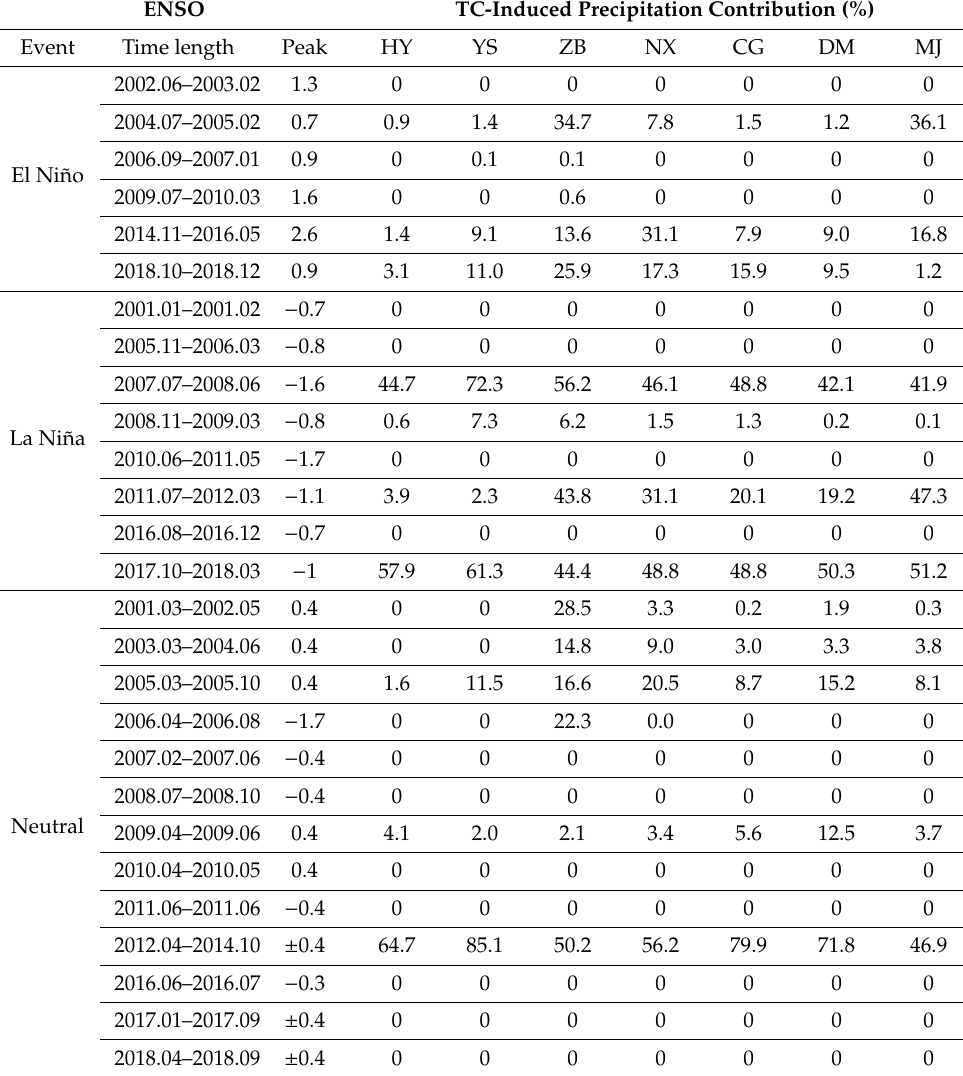
Table 3. ENSO and TC-induced precipitation